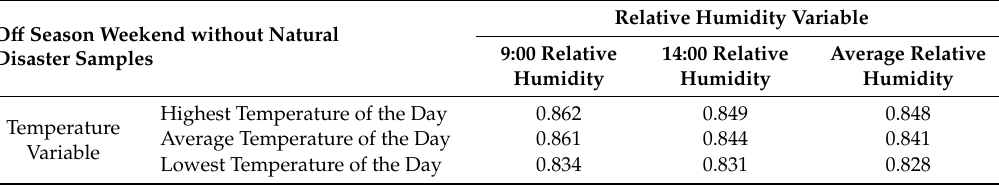
Table 4. Summary for the Adj- R 2 value of different regression models (second peak season weekend without natural disaster samples).